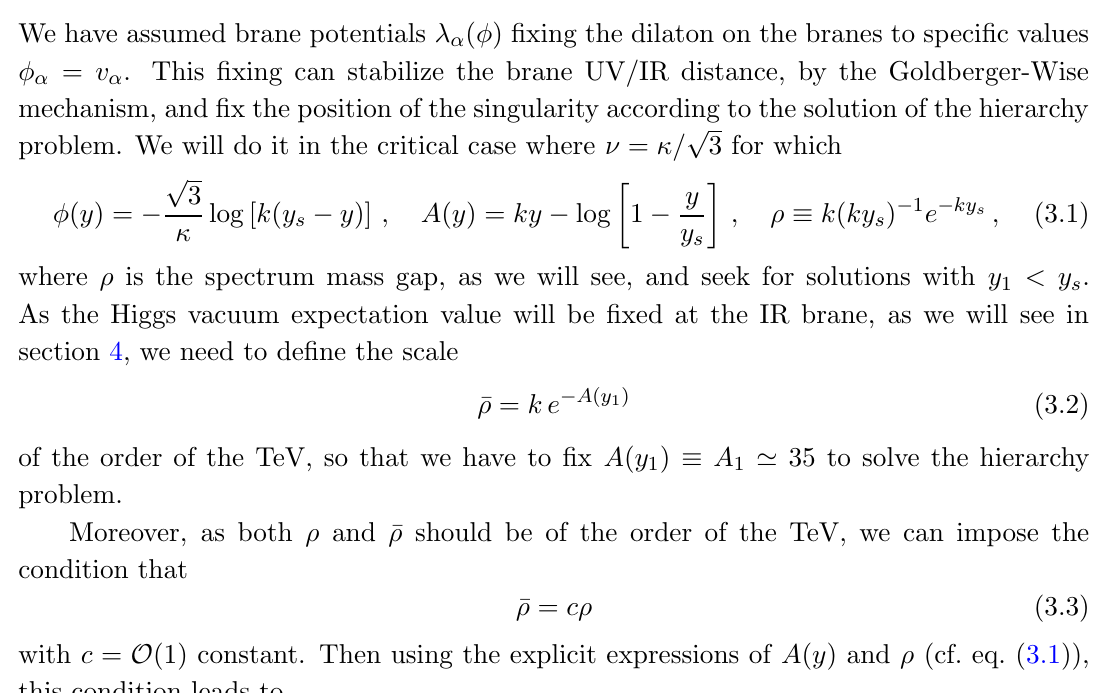
p 3 and ky s = 31 : 55,